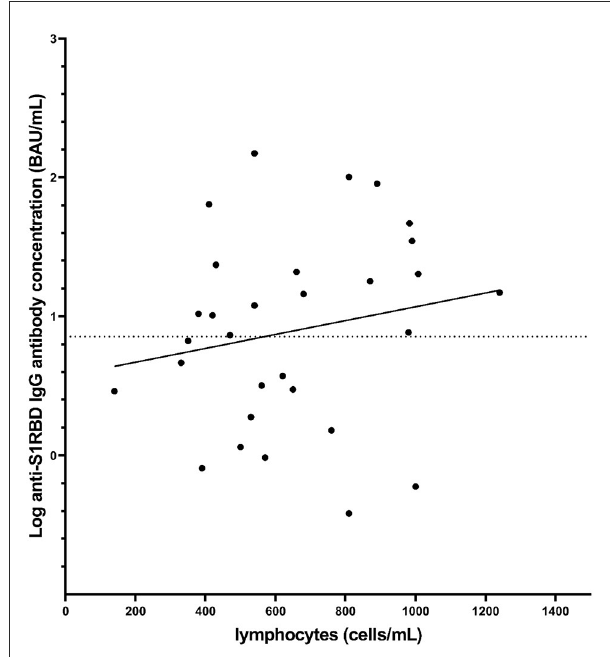
FIGURE2 Distribution of anti-S1RBD IgG antibody levels measured after the second vaccination dose as a function of lymphocyte count also measured after the second vaccination dose in MS volunteers receiving fingolimod ( n = 30). The dotted line represents the cut-off value (7.1 BAU/mL). The solid line represents a best fit line based on simple linear regression ( p =